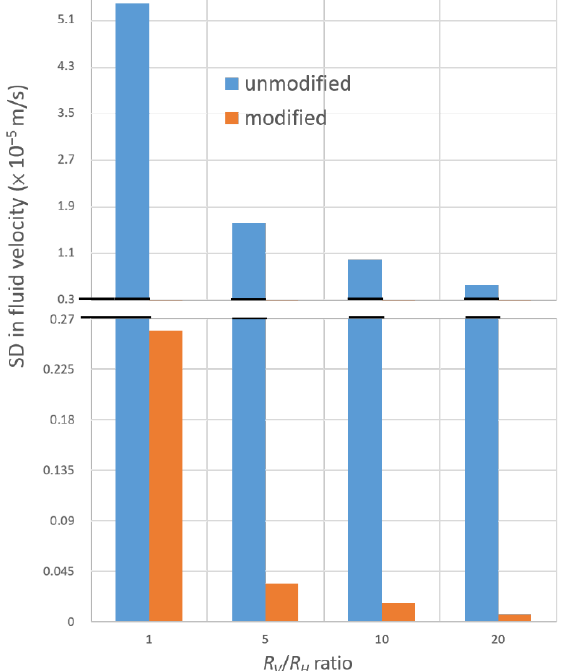
Figure 8. Comparison of SDs for unmodified and modified chips with four different ratios of R V / R H . y-axis scales are different in the top and bottom panels.